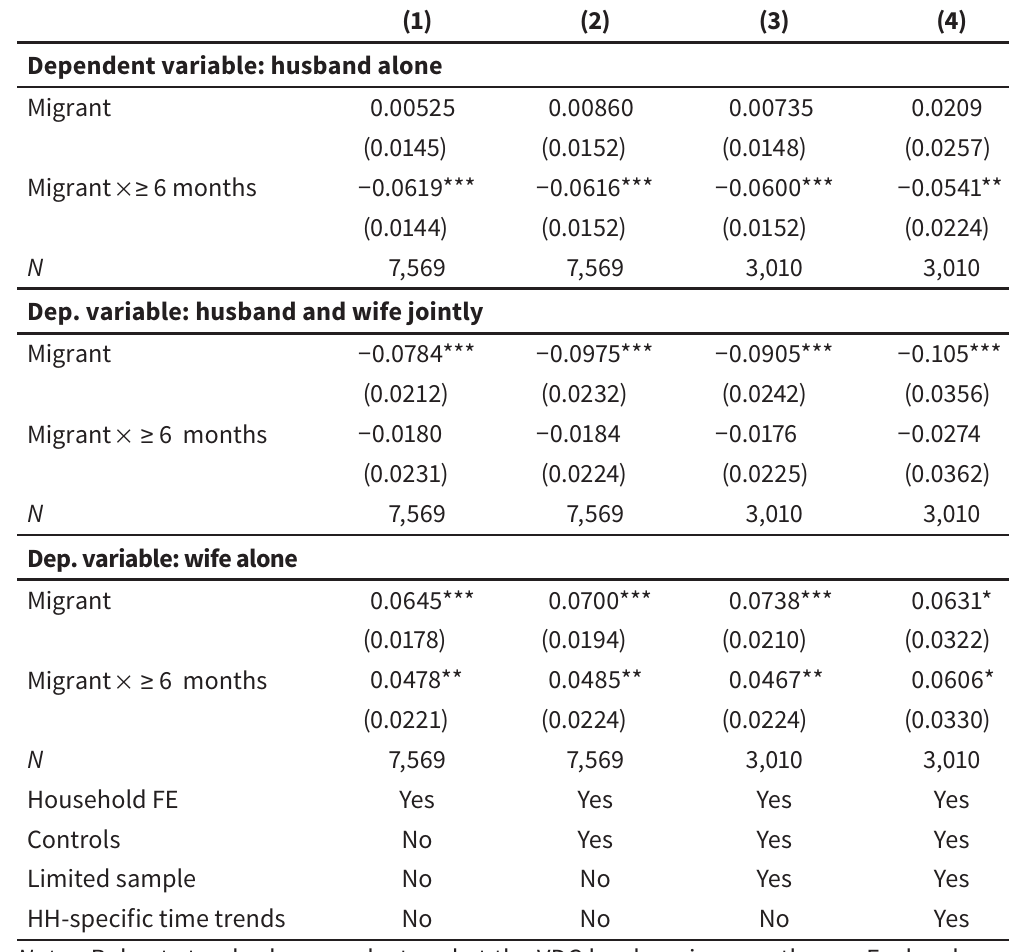
Table 6 Heterogeneity by trip length: change in decision-making (all categories) (1) (2) (3)